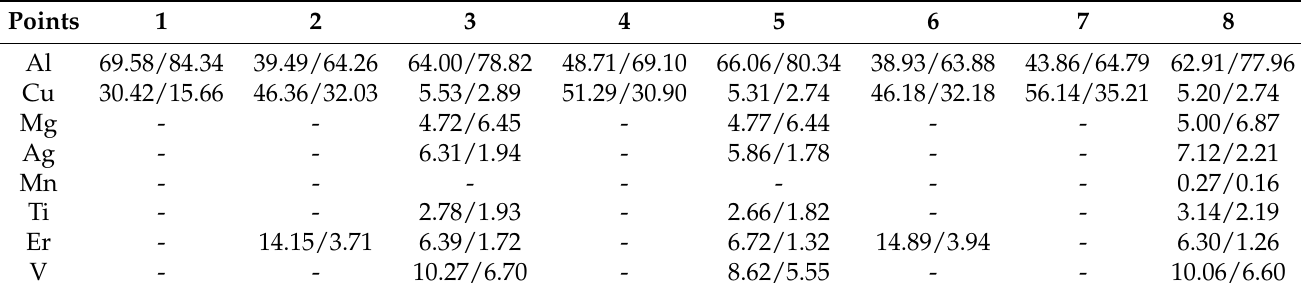
Table 3. EDS analysis (wt %/at %) of red points marked in Figure 5.